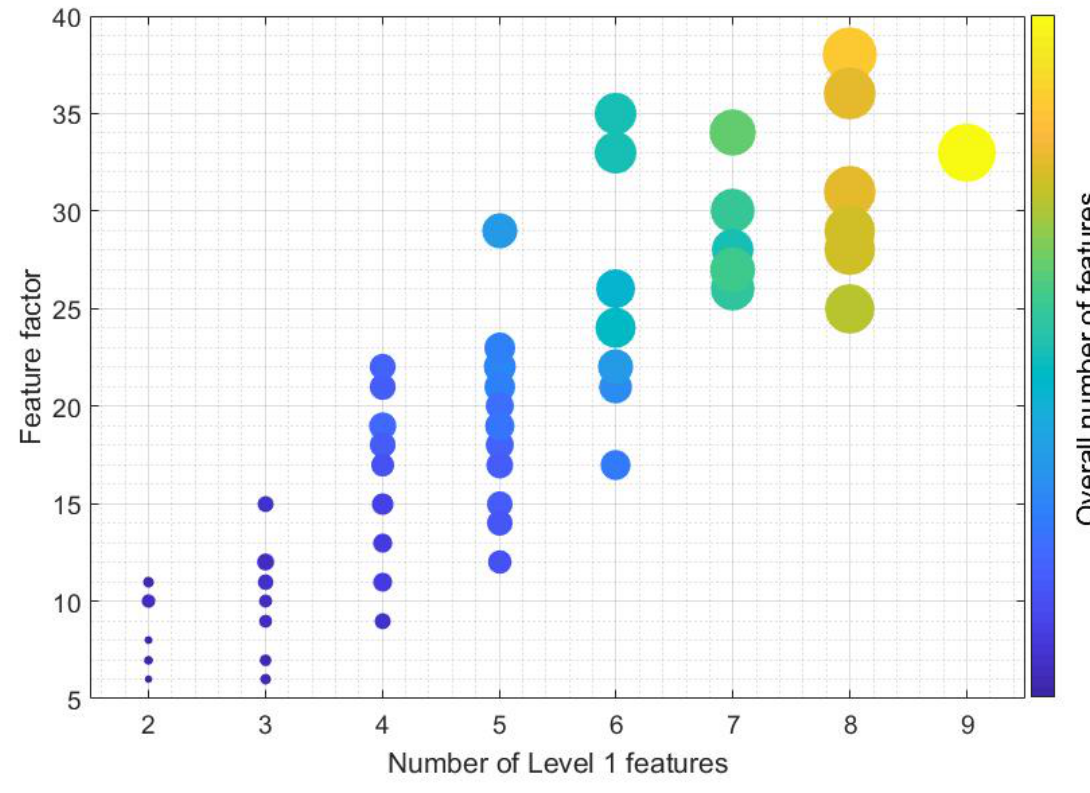
Figure 5. The relationship among the number of level 1 features and the Feature Factor.